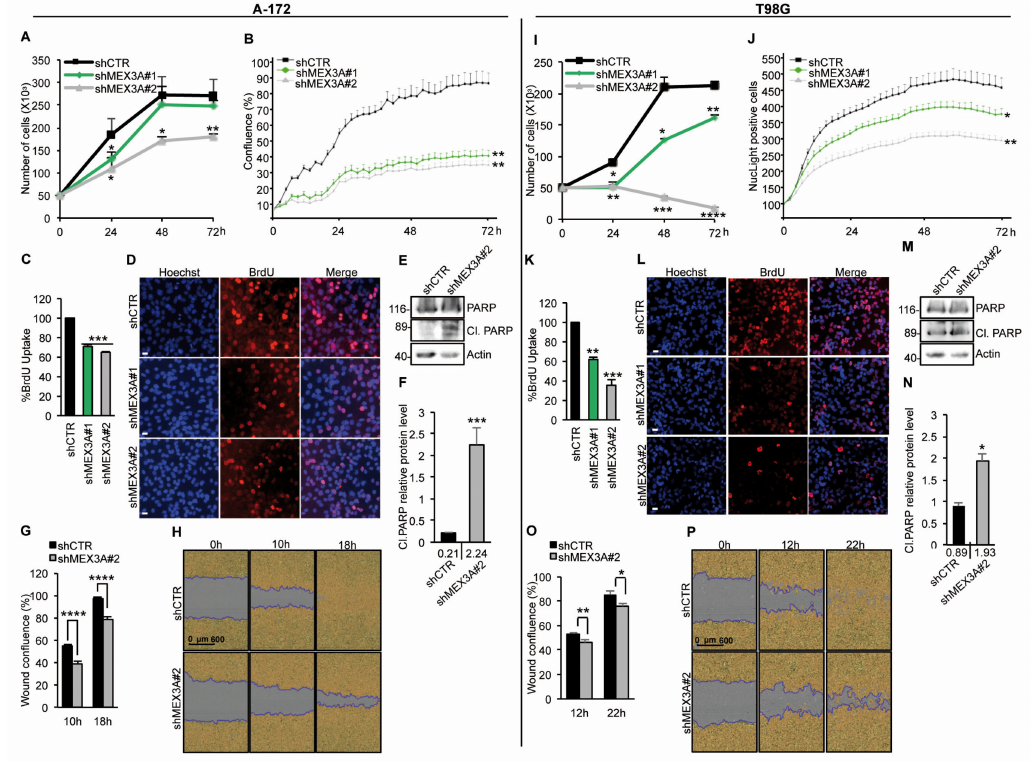
Figure 6. MEX3A impinges the proliferation of human A-172 and T98G GB cells. ( A , I ) A-172 ( A ) and T98G ( I ) cells were counted by trypan blue at the indicated time points to evaluate the growth